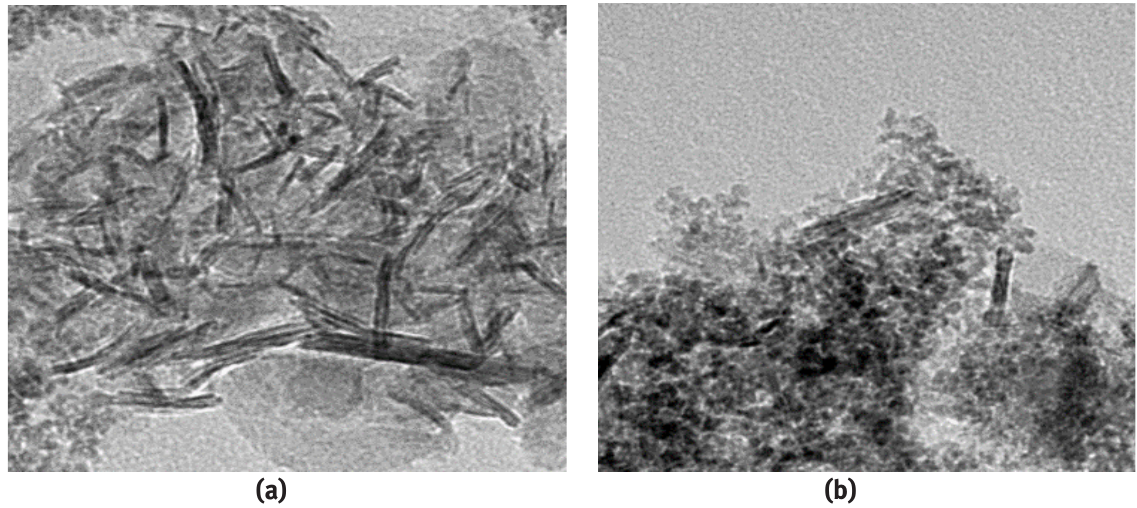
Figure 2: TEM images, (a) at pH=1.5 (image dimensions: 132.5 nm x 132.5nm), (b)at pH=7 (image dimensions 1.1μm x 1.1μm).